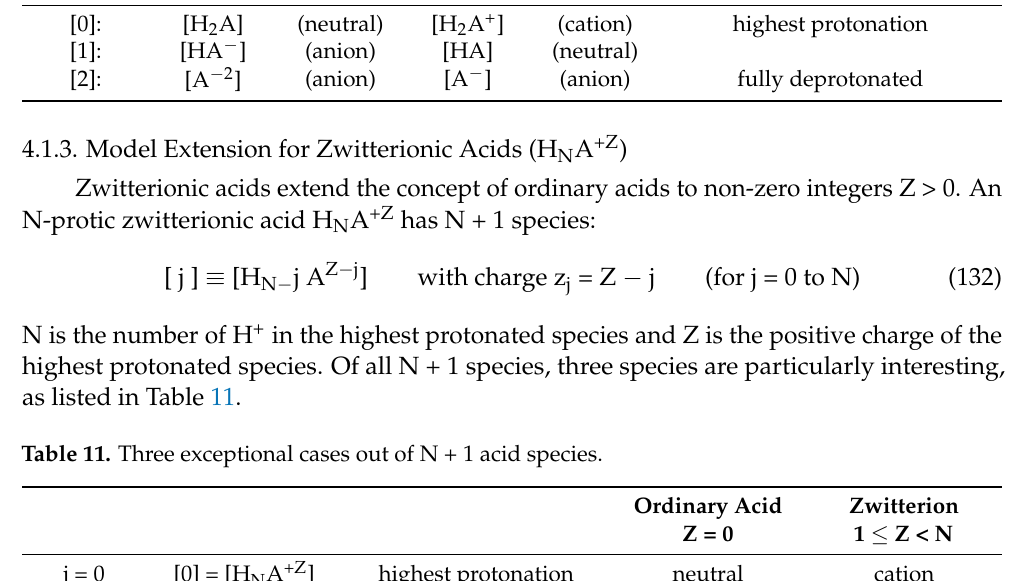
Table 9. Diprotic acids (N = 2): ordinary acid vs. zwitterion (simplest amino acid). Diprotic Acid